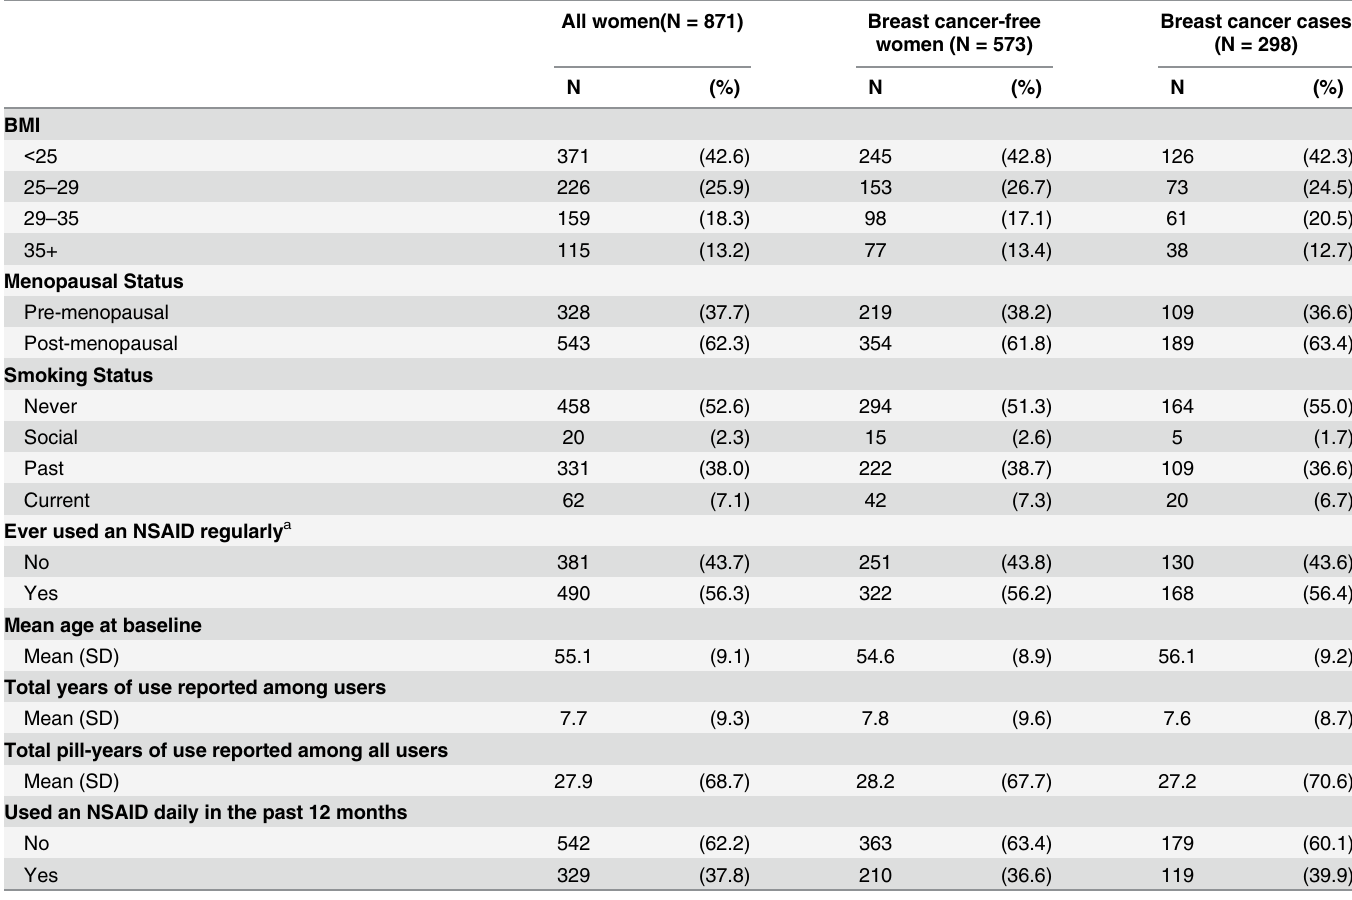
Table 1. Demographic characteristics of women in the discovery set (N =